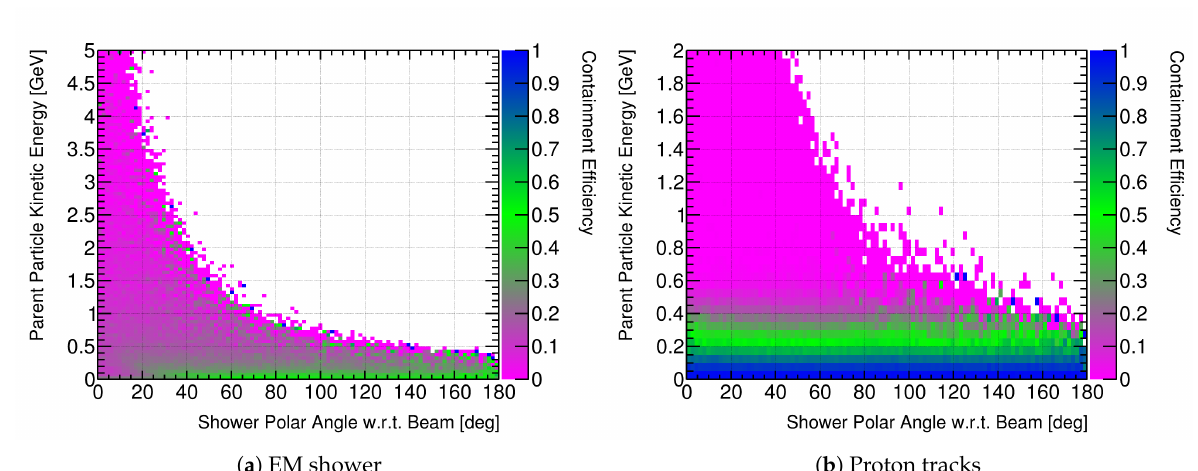
Figure 29. Containment efficiency for EM showers and proton tracks produced by an interaction within the ArgonCube 2 2 active volume, as a function of initiator particle energy and angle w.r.t the incoming beam direction. Note that if energy is deposited within the 2 2 active volume, it is classed as ×